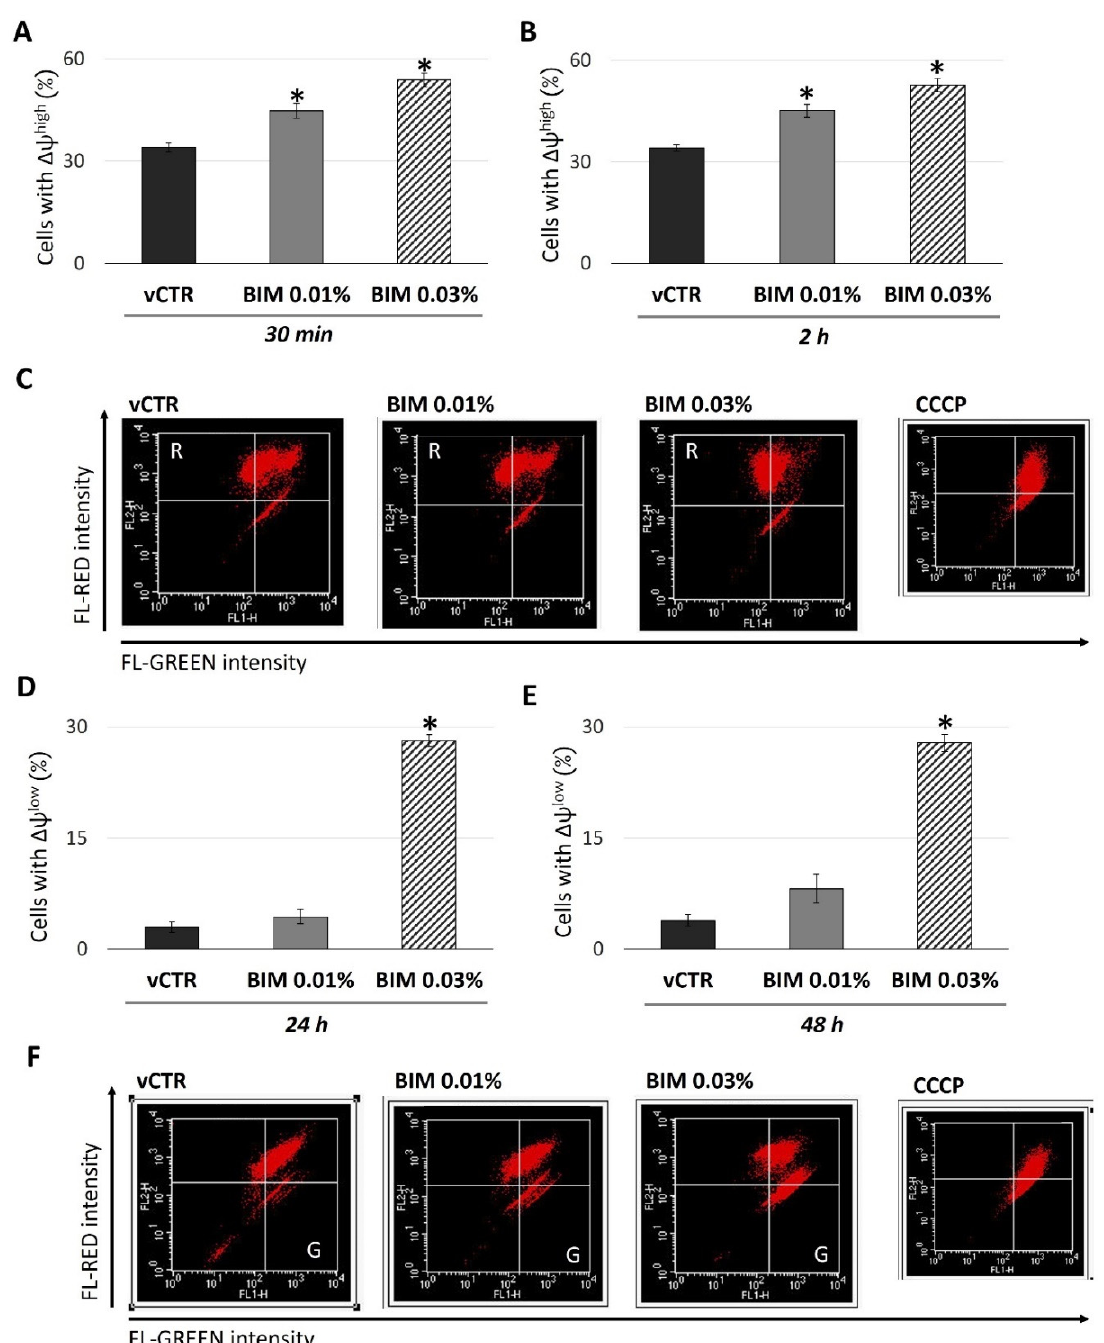
significant and marked drop in ∆Ψ m was observed in BIM 0.03% exposed groups at 24 (Figure 3D) and 48 h (Figure 3E,F), expressing a percentage of cells with ∆Ψ mlow near to 30% versus vCTR.